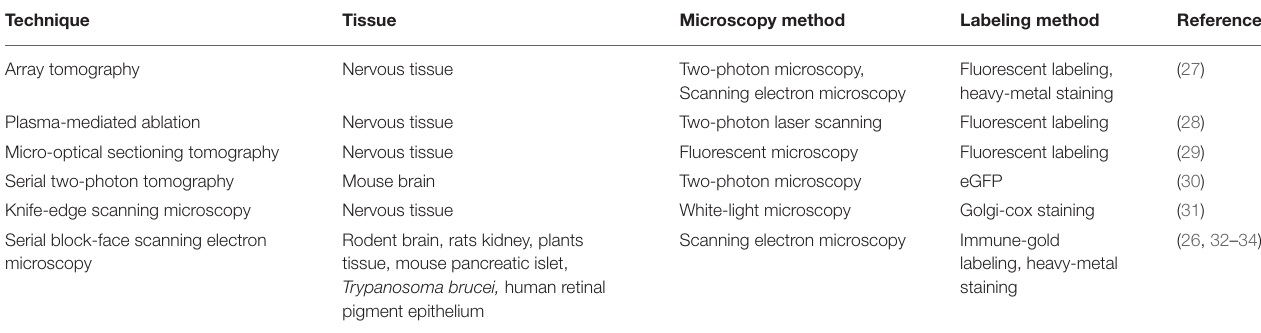
TABLE 2 | Serial sectioning methods for three-dimensionally reconstruction of tissues image.